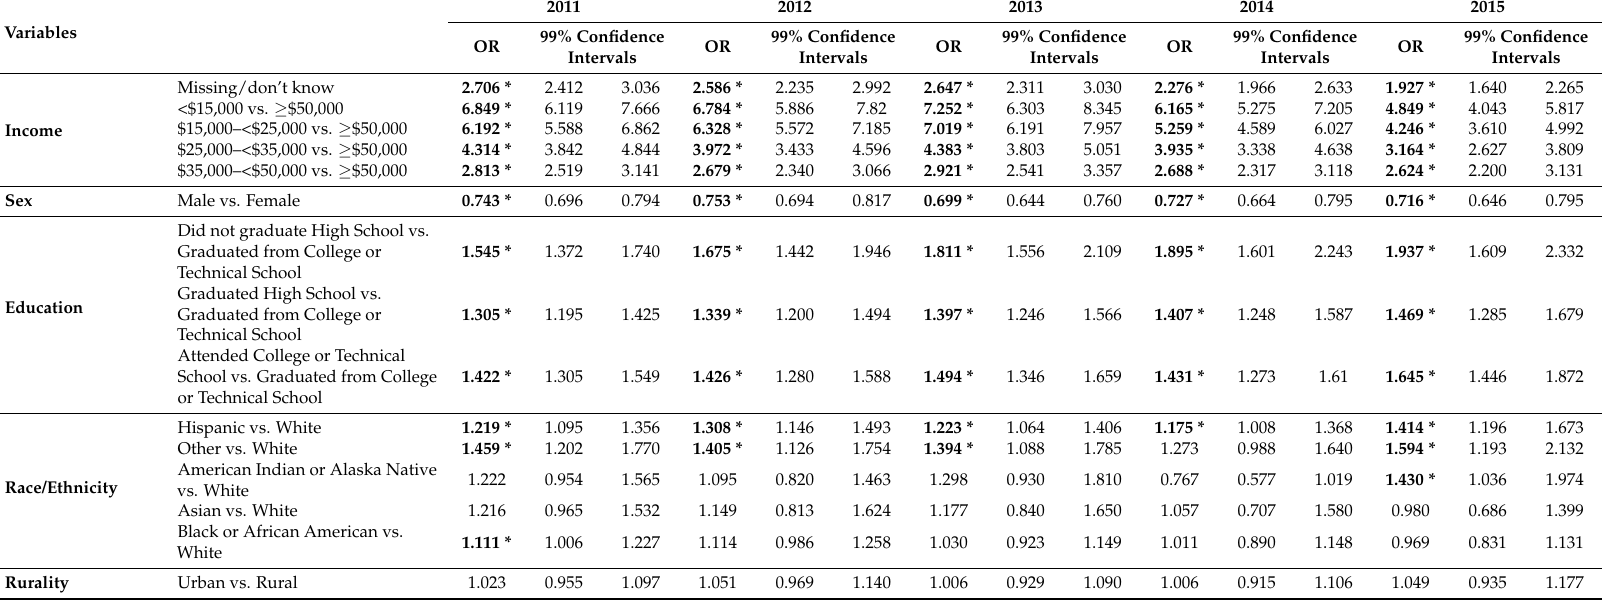
Table 4. Adjusted Analysis for Forgone Care among individuals aged 19–64 years of age including state Medicaid